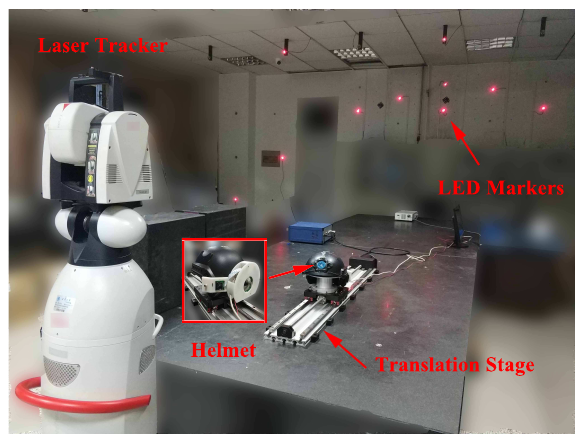
Figure 13. Static measurement experiment scene.